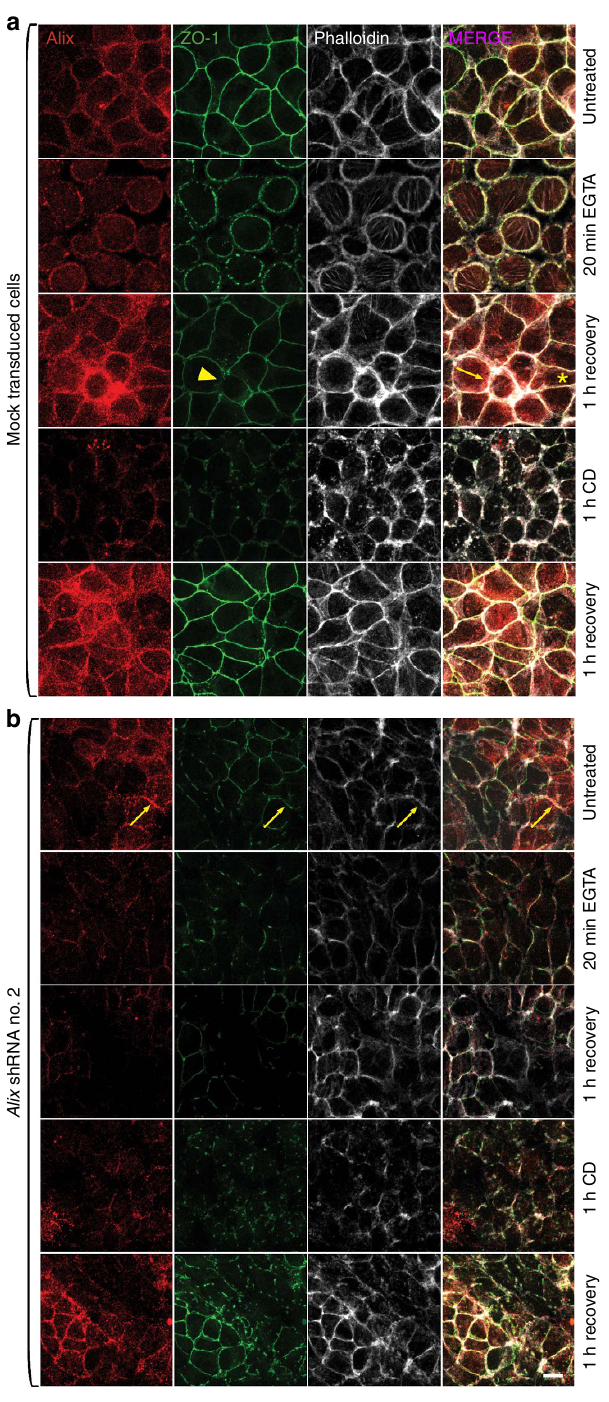
Figure 8 | Alix is involved in TJ reassembly. ( a , b ) Z310 CP cell line transduced with mock or Alix shRNA lentiviral constructs. Cells were treated with 2mM EGTA or 10 m M cytochalasin D (CD) and allowed to recover. Scale bar, 10 m m.